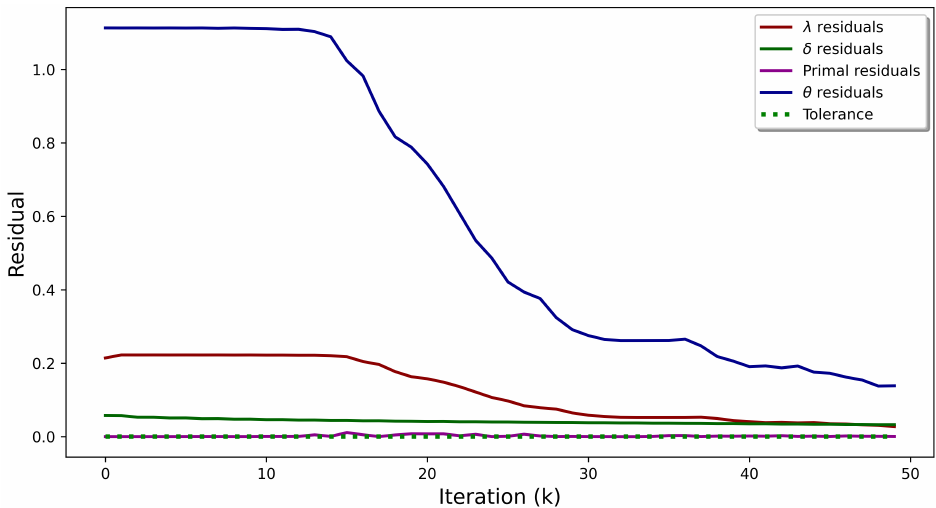
Figure 5. ADMM dual variables convergence rates from iteration 0 to